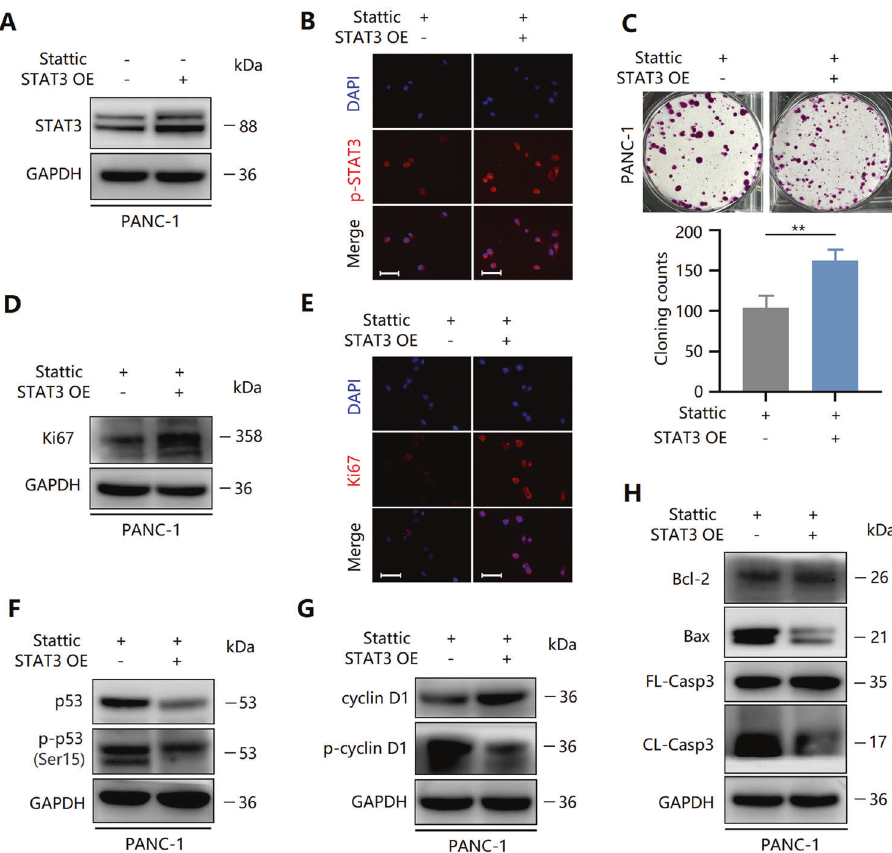
Fig. 8 Lentivirus-mediated overexpression of STAT3 partially reverses the anti-tumor effect of Stattic. A Expression of STAT3 without Stattic-treated PANC-1 cells after transfection with lentivirus. B Immunocytochemical staining of p-STAT3 in Stattic-treated PANC-1 cells after transfection with lentivirus. Bar = 50 μ m. C Colony formation assay revealing the proliferation of Stattic-treated PANC-1 cells after transfection with lentivirus. D The expression of Ki67 in Stattic-treated PANC-1 cells after transfection with lentivirus. E Immunocytochemical staining of Ki67 in Stattic-treated PANC-1 cells after transfection with lentivirus. Bar = 50 μ m. F Expression and phosphorylation of p53 in Stattic-treated PANC-1 cells after transfection with lentivirus. G Expression and phosphorylation of cyclin D1 in Stattic-treated PANC-1 cells after transfection with lentivirus. H Proteins levels of Bcl-2, CL-Casp3, Bax, and FL-Casp3 in PANC-1 cells subjected to the indicated treatments. ** P <